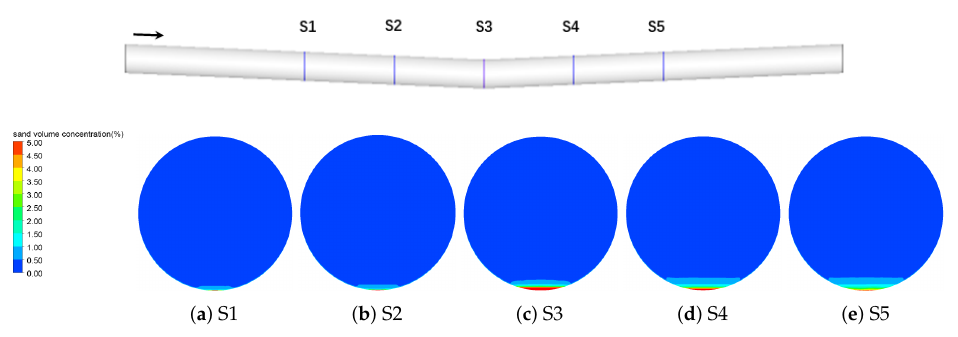
Figure 13. Sand volume concentration contours at different cross-sections of V-inclined pipe (inflow velocity = 0.4